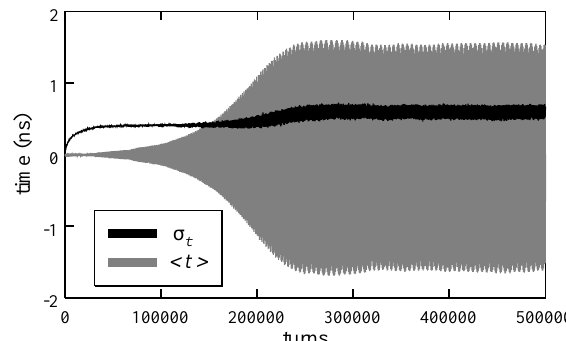
FIG. 2. Simulation of coupled-dipole Robinson instability for passive Landau-cavity operation with the Aladdin lattice, for a ring current of 100 mA and Landau-cavity tuning angle of 2 86 ± . The time offset of the bunch centroid (cid:7) t (cid:8) and bunch length s t are plotted every 100